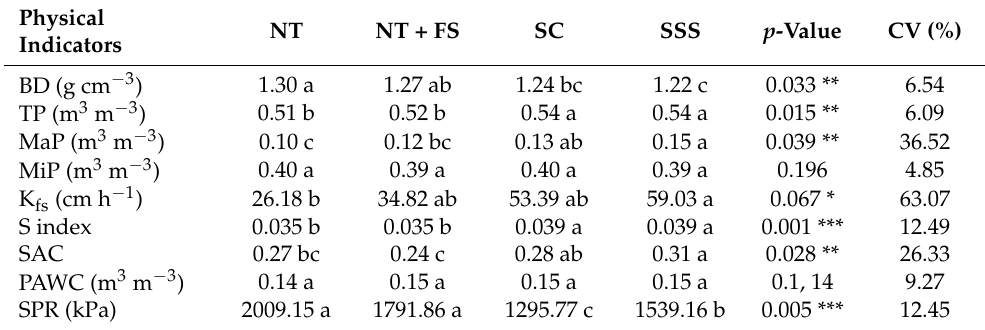
Table 5. Physical indicators for the soil mechanical interventions at a depth of 0.05–0.15